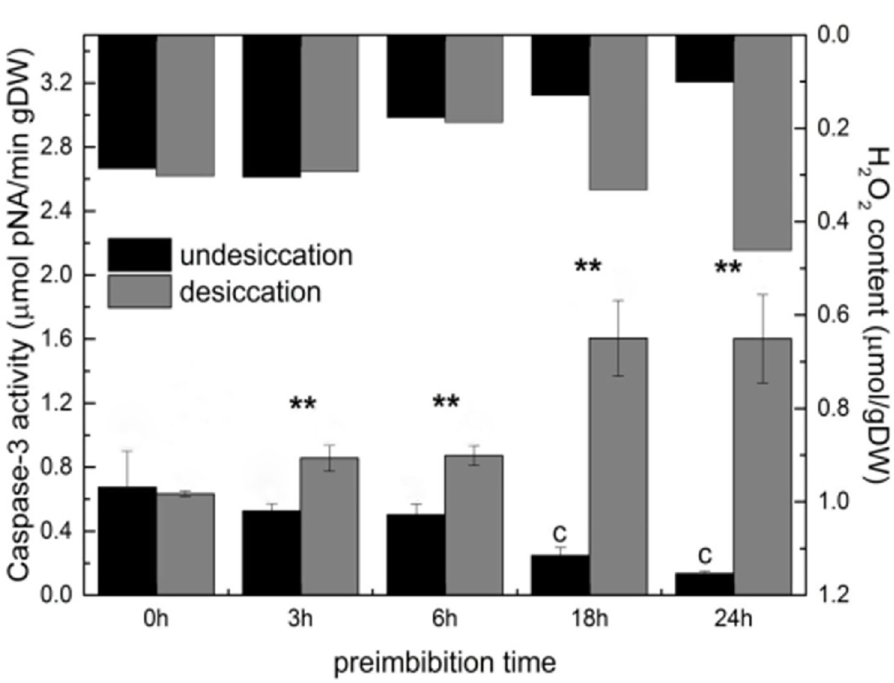
Fig 9. Activity of caspase-3 in mung bean hypocotyls in different preimbibition and dehydration states. �� P < 0.01.